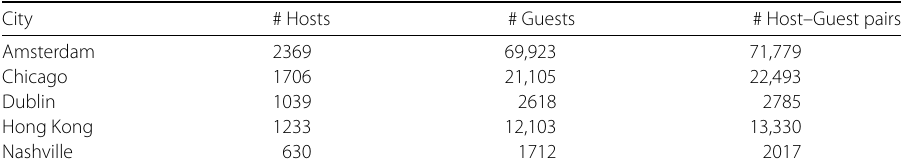
Table 1 Number of hosts, guests, and host–guest pairs annotated for each city analysed City #